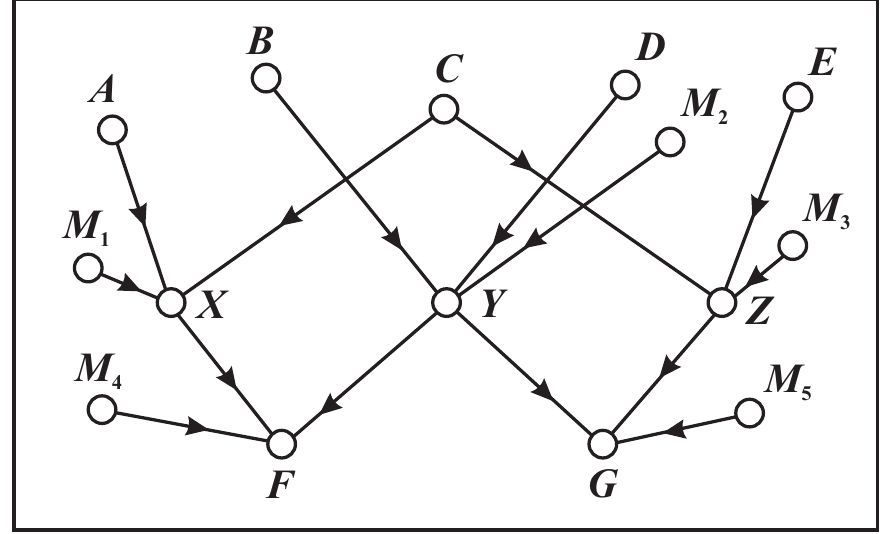
Figure 26. A causal network derived from the electronic circuit in Figure 25. Redrawn from Figure 5.7 in [59](p. 264), with permission from the copyright holder,